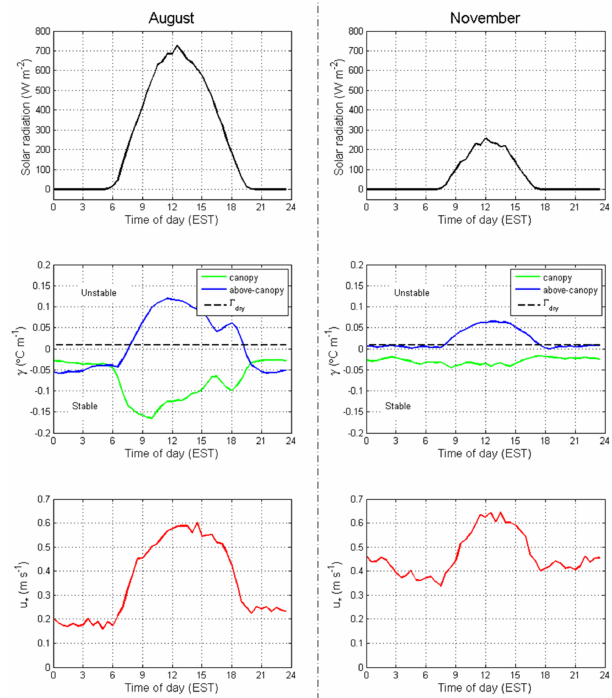
Fig. 4. Mean diurnal cycles of NO x , NO , and O 3 mixing ratio pro- files from the UMBS AmeriFlux site for August and November 2008. The area between the dashed lines in the plots denotes the crown layer. Gaps in the data below the crown layer in November are due to failures in the 4 and 15 m switching valves.